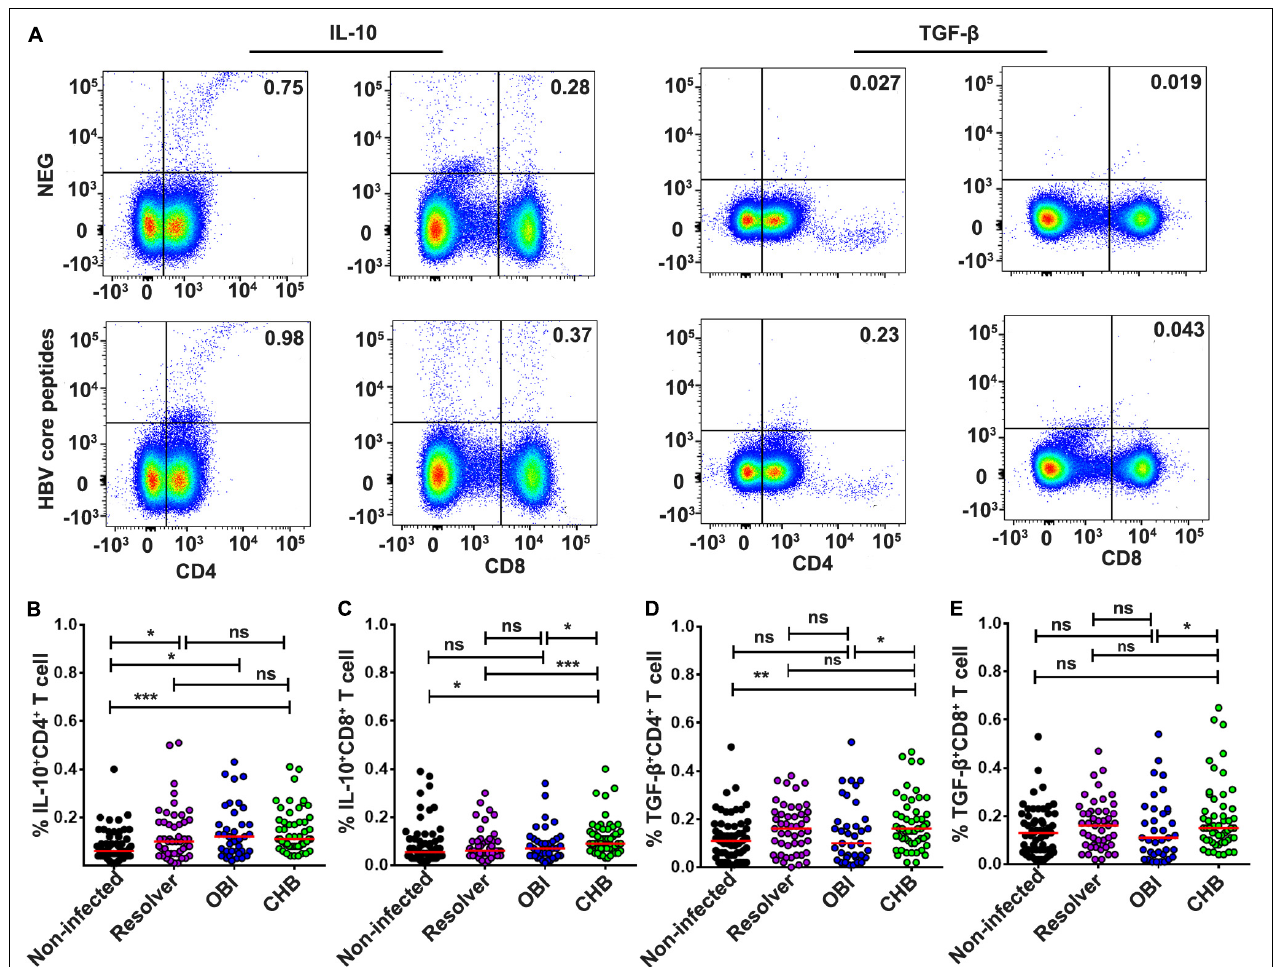
FIGURE 5 | Intracellular IL-10 or TGF- β secretion CD4 + /CD8 + suppressor T-cell responses to HBV core peptides. (A) Representative flow-cytometric analysis of reactivity of CD4 + /CD8 + T cells from an OBI donor stimulated with negative control and HBV core peptides. (B,C) IL-10 secreting CD4 + or CD8 + T cells. (D,E) TGF- β secreting CD4 + or CD8 + T cells. A median of frequency in each group is indicated compared with the Mann–Whitney test. Statistically significant differences are shown with asterisks (* P < 0.05, ** P < 0.01, and *** P < 0.001); ns, no significant